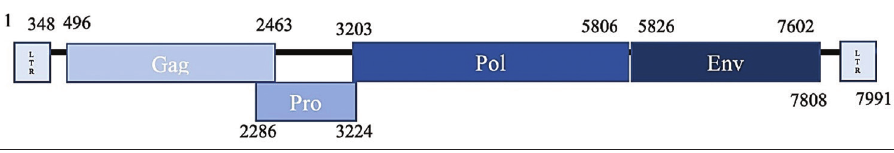
Figure-3: Genome mapping of simian endogenous retroviruses isolated from pig-tailed macaque of Mn B1 and Mn B140910. Nucleotide sequence position is indicated by number for each gene.